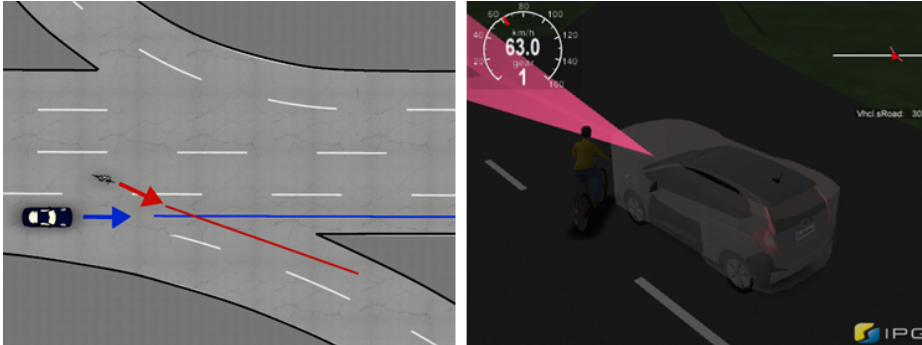
Figure 4. Field of view and top view about the first scenario when Tesla crashed into a